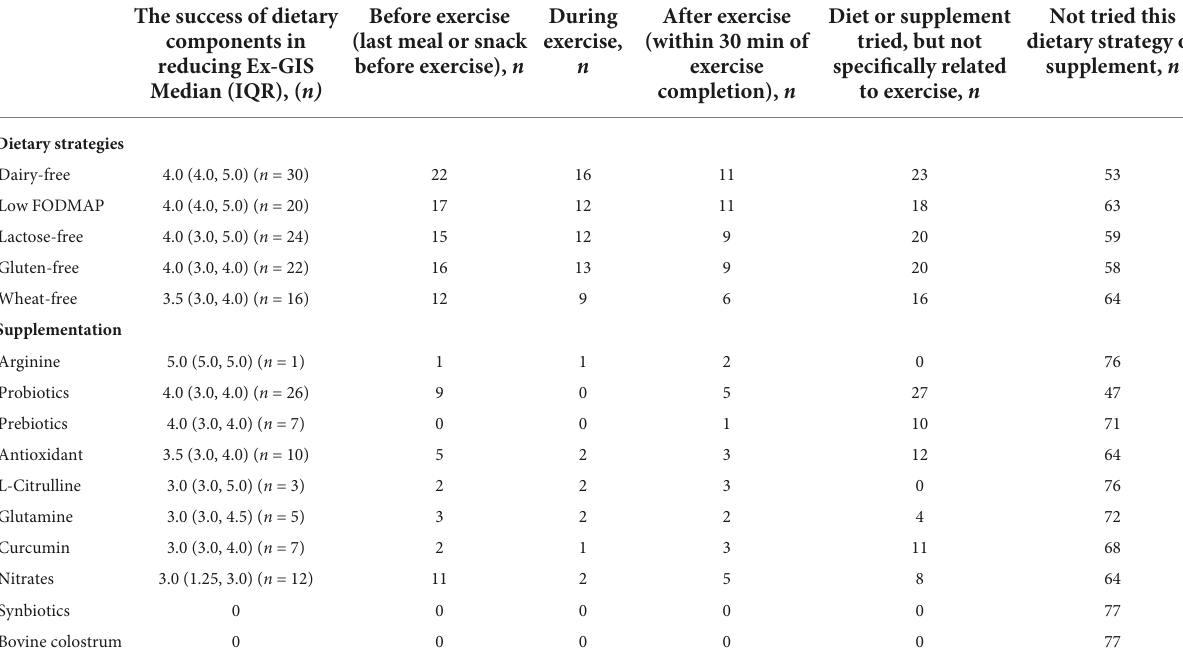
TABLE 5 Specific dietary strategies trialed, and supplements used to reduce the development of exercise-associated gastrointestinal symptoms (listed in order of success at reducing symptoms). Not tried this Diet or supplement Before exercise During After exercise The success of dietary dietary strategy or tried, but not (last meal or snack exercise, (within 30 min of components in n supplement, n specifically related before exercise), n exercise reducing Ex-GIS to exercise, n completion), n Median (IQR), ( n)